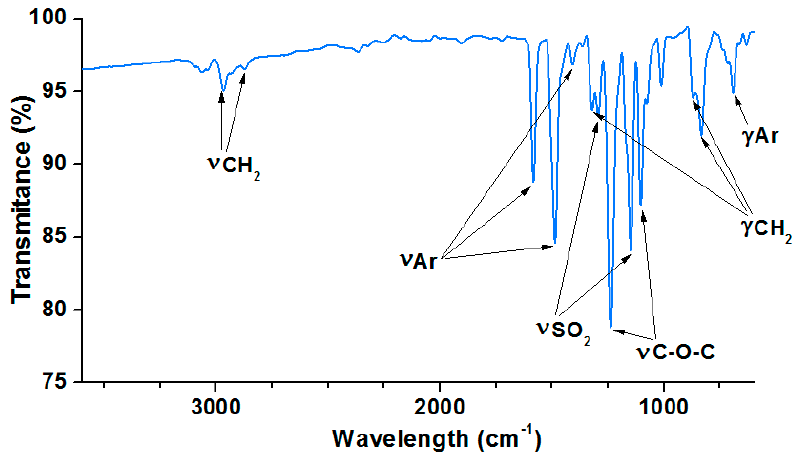
Figure 6. ATR/FT–IR spectra of the bisphenol Z polysulfone.